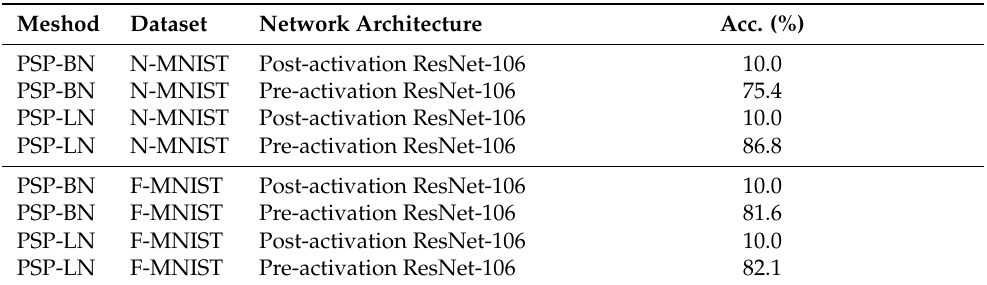
Table 3. Performance comparison using post-activation and pre-activation residual blocks. We use ResNet-106 on N-MNIST and F-MNIST datasets,